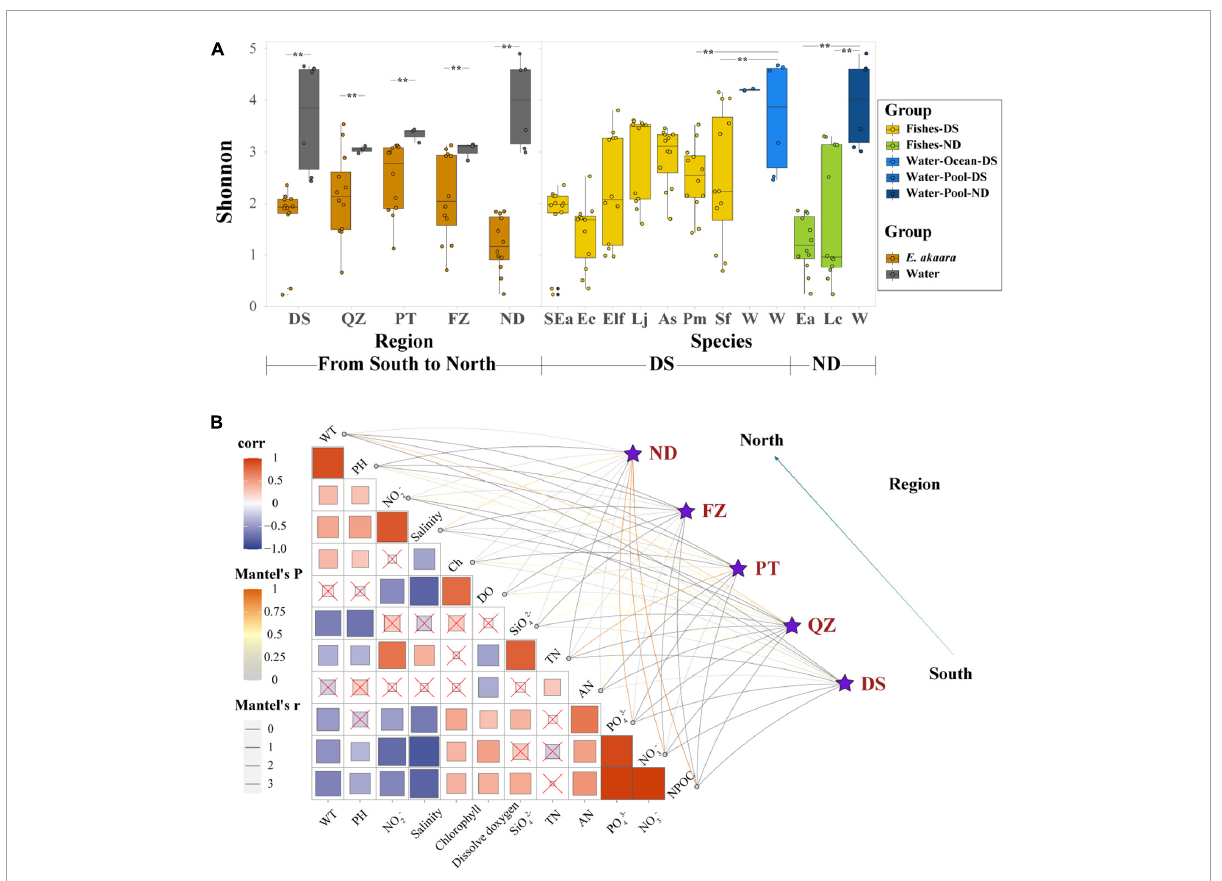
FIGURE3 Habitat filtering by genetic selection and water environmental factors may be the major driver shaping the gut core microbial communities of marine commercial fish with similar diets. (A) α -Diversity comparison based on the Shannon diversity index with dot plots and box plots. Each fish group represents 9 fish individuals mixed by 12 sample individuals, each water group represents 3–6 samples depending on their aquaculture environment, ** p < 0.05. (B) Environmental drivers of the microbial communities from south to north (Bray–Curtis distance) and environmental factors were analyzed with Mantel tests. The edge width corresponds to the R -value, and the edge color denotes the statistical significance. The color gradient indicates Pearson correlation coefficients among the environmental factors indicate no significant correlation at 0.05